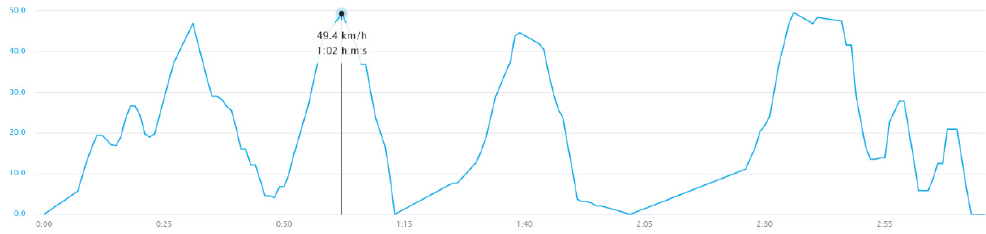
Figure 2. Changes in speed on the road test route.